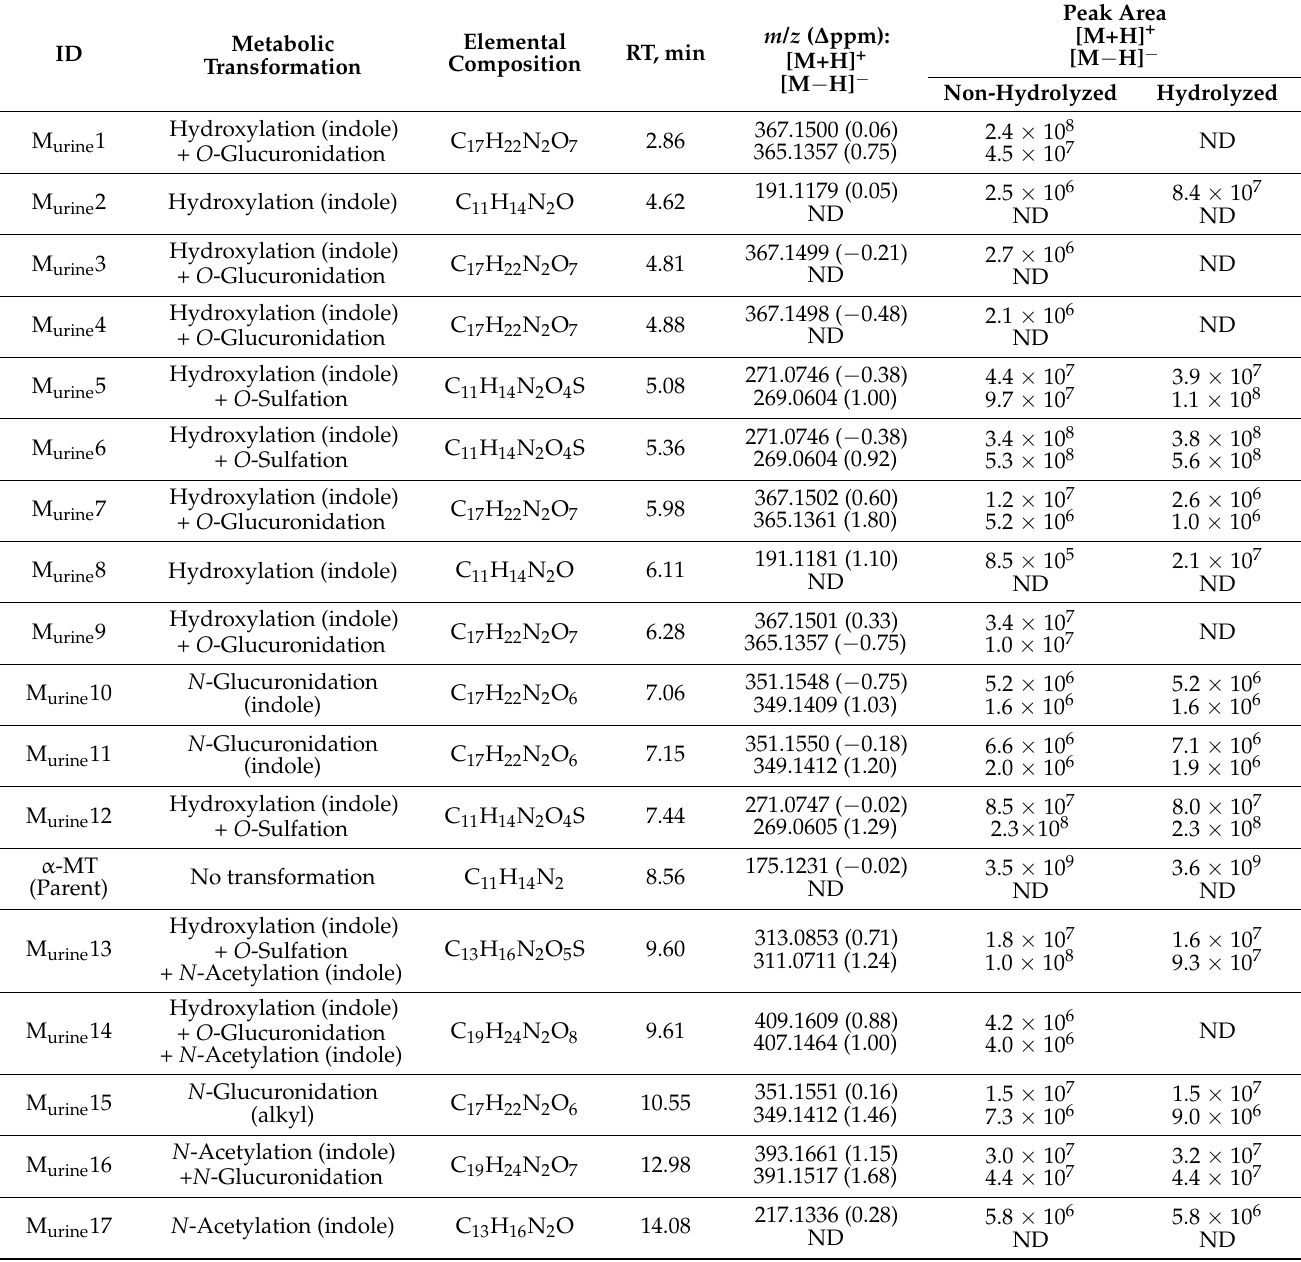
Table 2. Metabolic transformation, elemental composition, retention time (RT), accurate mass of molecular ion in positive- and negative-ionization modes ([M+H] + and [M − H] − , respectively) with mass error, and liquid chromatography–high-resolution mass spectrometry peak area of α -MT and metabolites in postmortem urine with and without enzymatic hydrolysis with β